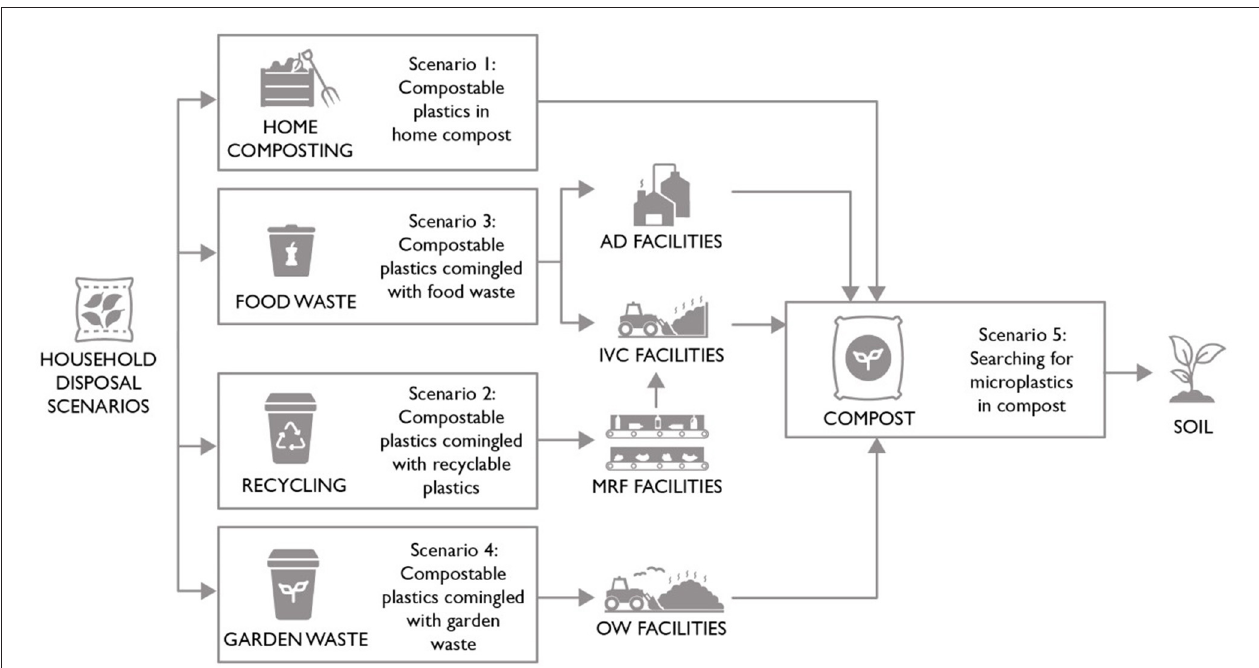
FIGURE 5 | Different scenarios of compostable plastic identification and sorting as part of a circular